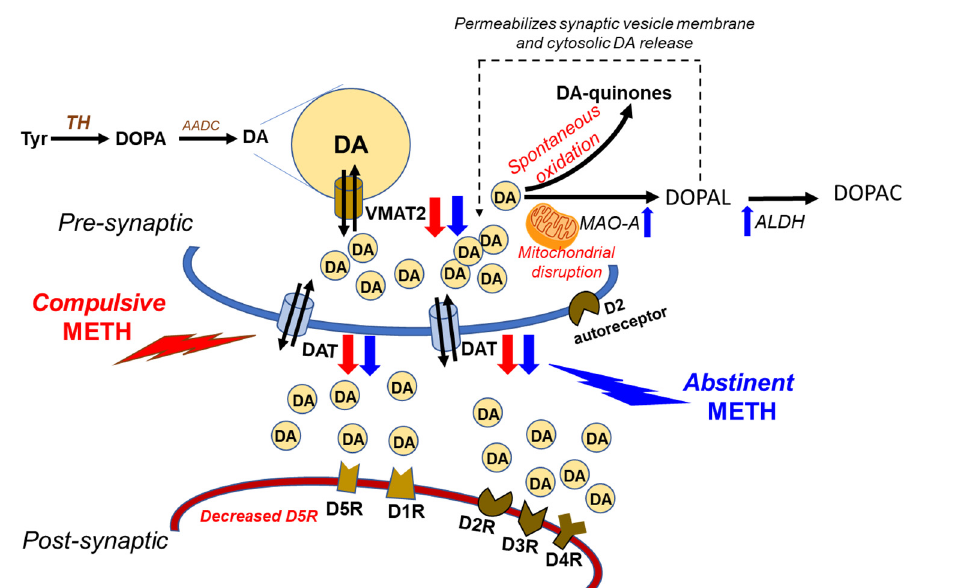
Figure 7. Schema illustrating potential mechanisms for the observed changes in the striatal dopaminergic system of METH self-administering rats. METH SA is accompanied by increased release of DA in dopaminergic terminals followed by DA release into the synaptic cleft where DA interacts with DA receptors. Increased cytosolic DA release is associated with enzymatic and non-enzymatic formation of reactive oxygen species known to cause significant decreases in VMAT2 and DAT protein levels as observed in both SR and SS rats herein. The differential expression of post-synaptic DA D1-like receptors (D1R and D5R) supports the notion that these genes might be differentially regulated. The decreased expression of the D2-like receptors, D3R and D4R, indicates that they might have undergone similar molecular adaptations in the presence of high levels of DA released in the dorsal striatum during METH SA.